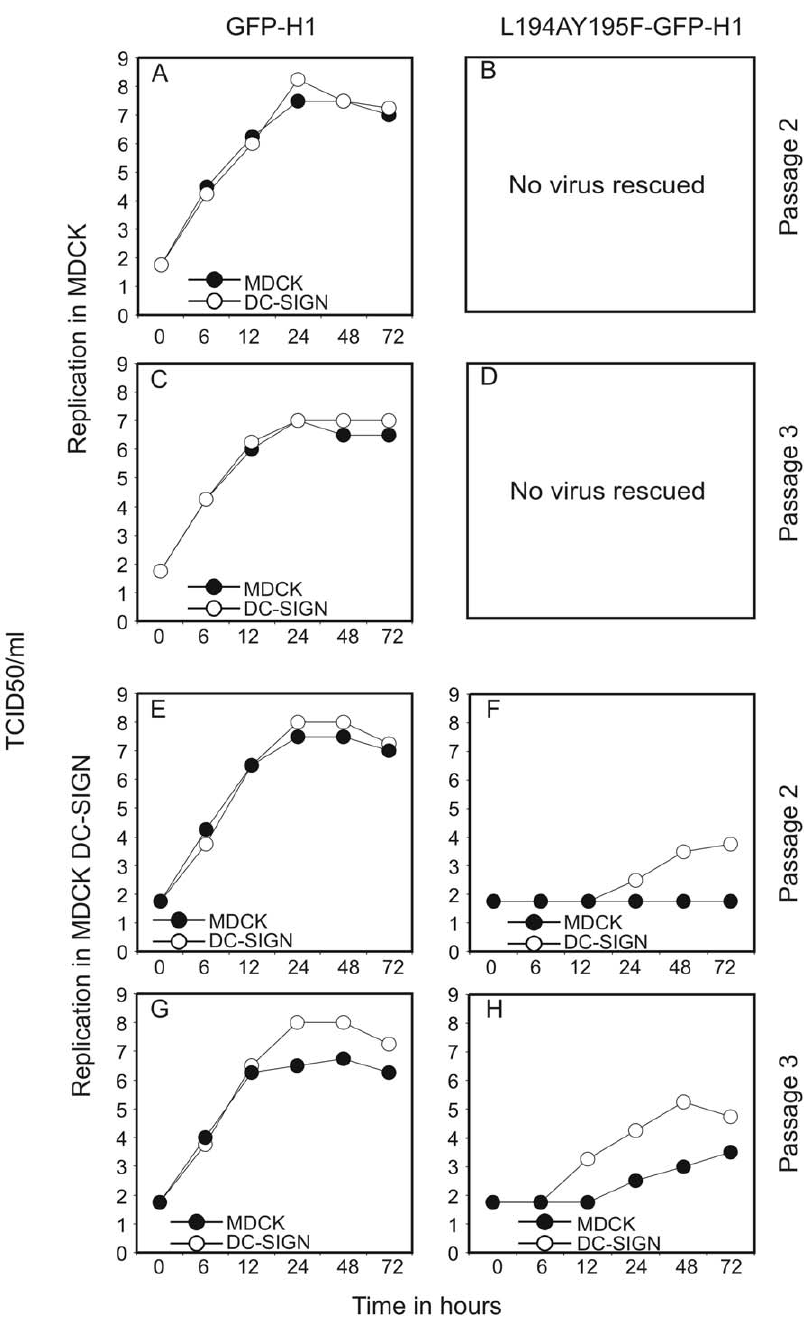
Figure 3. Replication kinetics of viruses GFP-H1 and L194AY195F-GFP-H1 in MDCK and DC-SIGN-expressing MDCK cells. After transfection of 293T cells with reverse genetics plasmids, culture supernatants of influenza viruses GFP-H1 (A, C, E, G) and L194AY195F-GFP-H1 (B, D, F, H) virus passaged in MDCK (A–D) and MDCK-DC-SIGN (E–H) cells were obtained and used to inoculate MDCK (solid symbols) or MDCK DC-SIGN cells (open symbols) at a moi of 0.01. At the indicated time points post inoculation culture supernatant were tested for the infectious virus titers to determine the replication kinetics. Virus L194AY195F-GFP-H1 could not be rescued in MDCK cells.